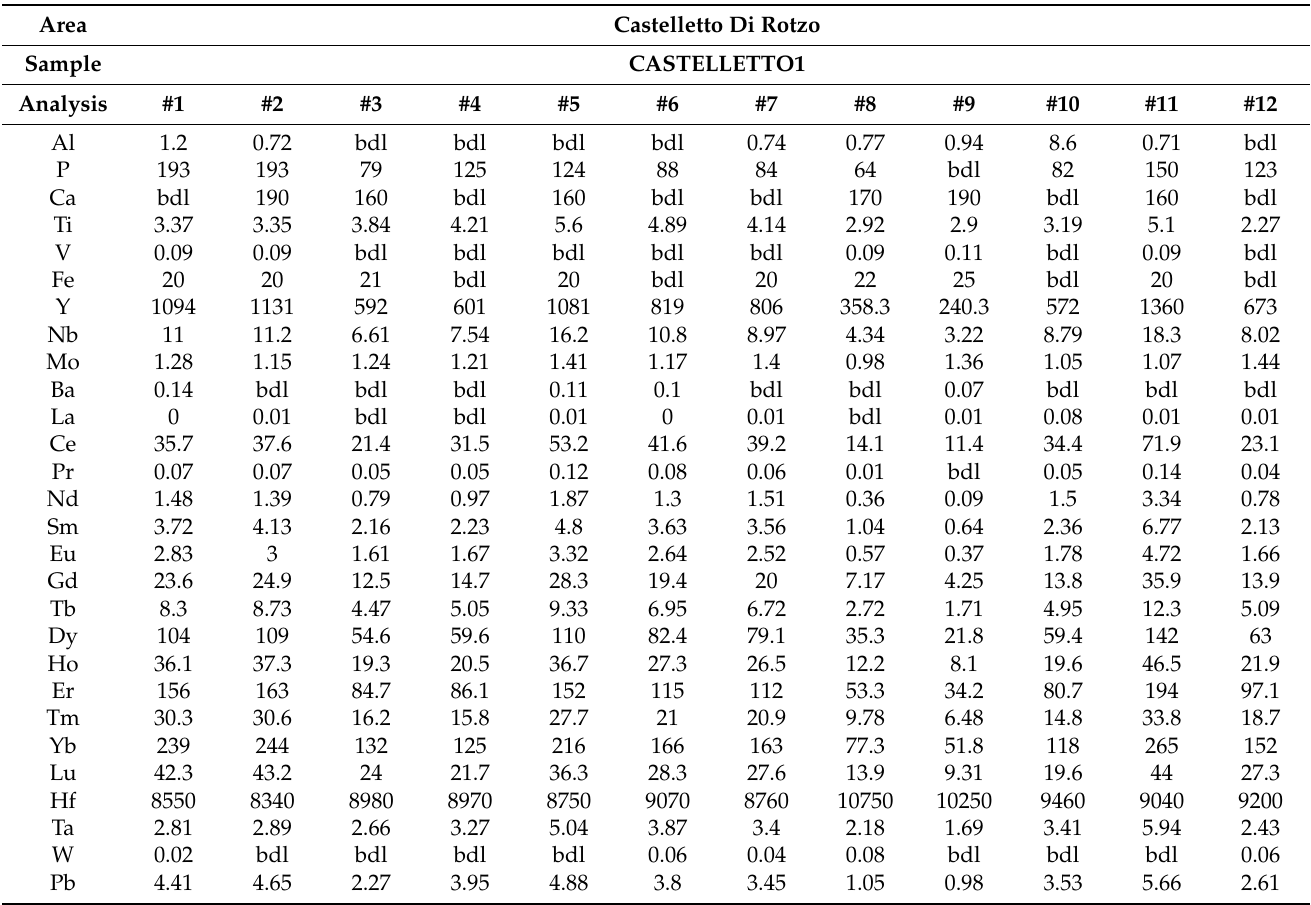
Table 3. LA- ICP-MS zircon analyses ( µ g/g) from Castelletto di